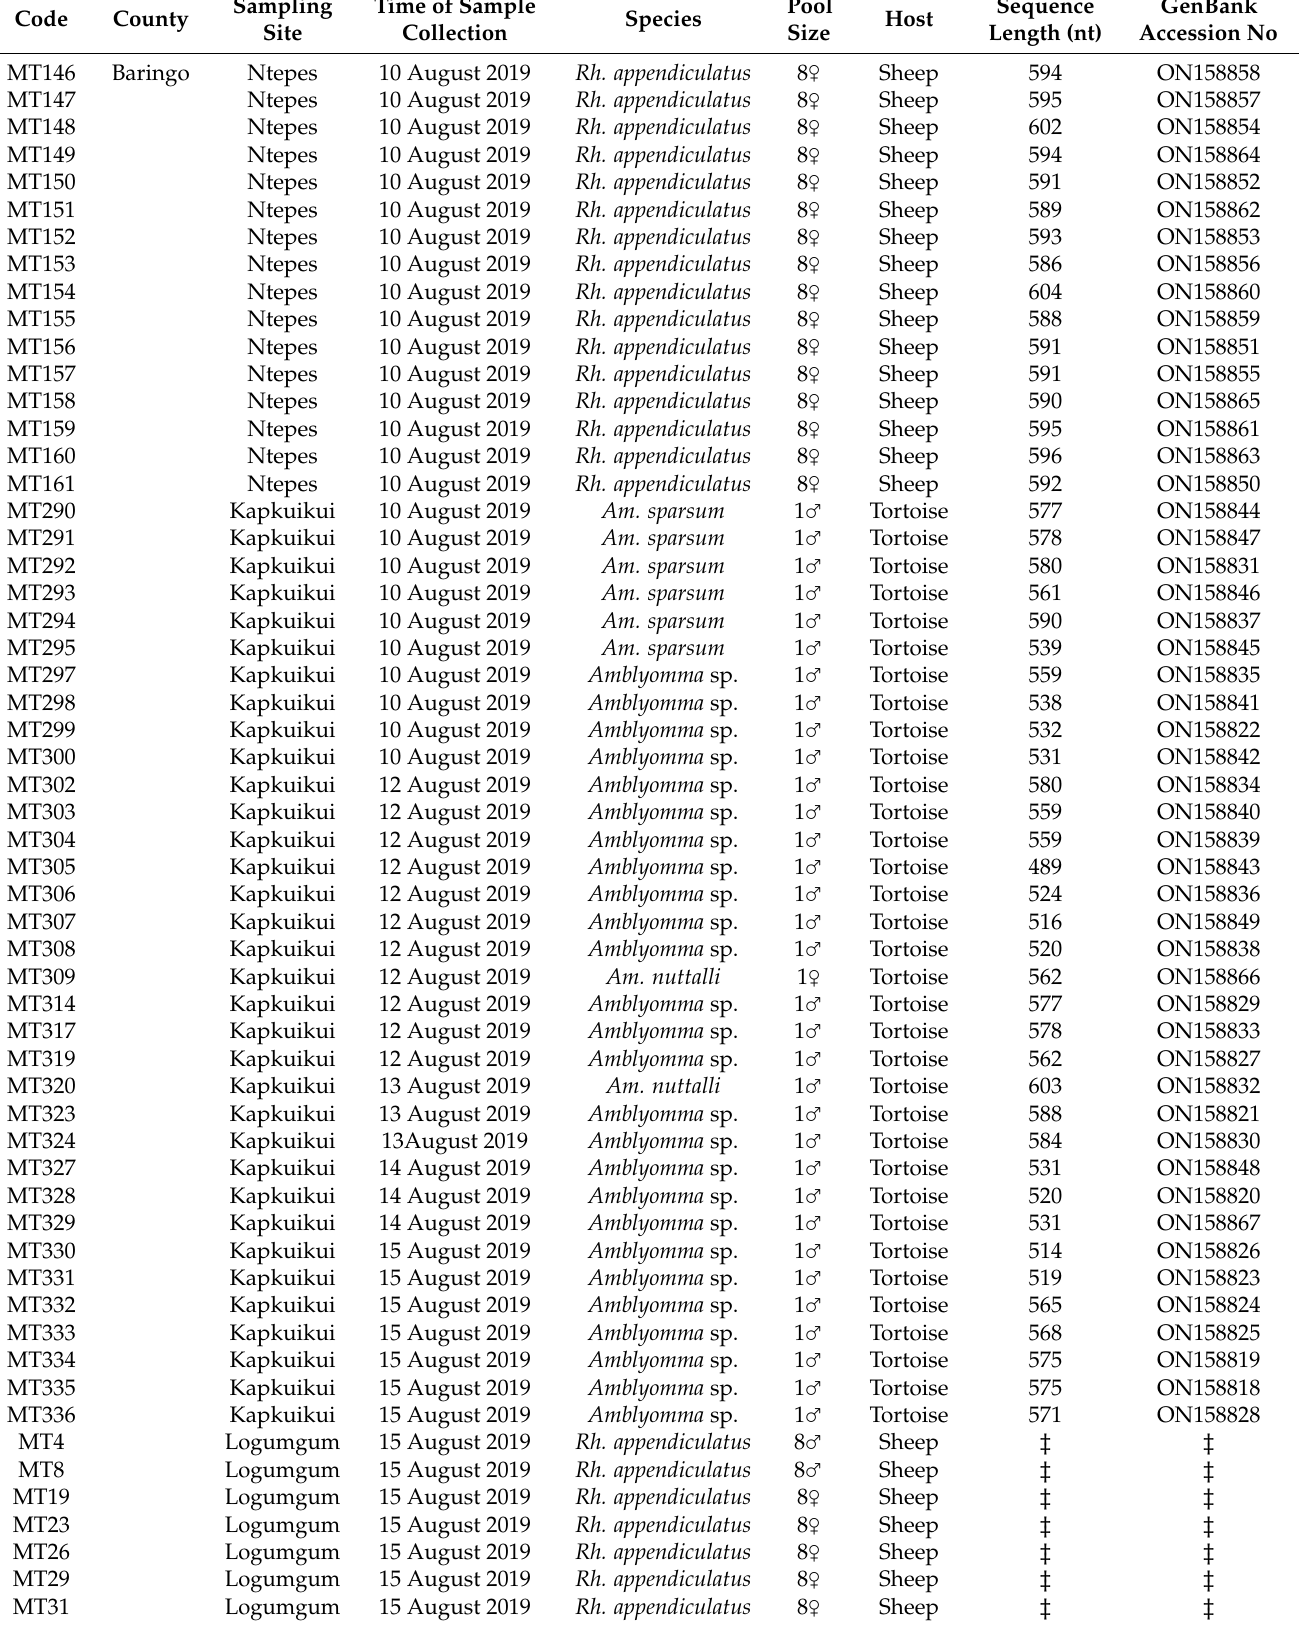
Table 2. Characteristics of JMTV-positive ticks and tortoises in Baringo and Kajiado counties,